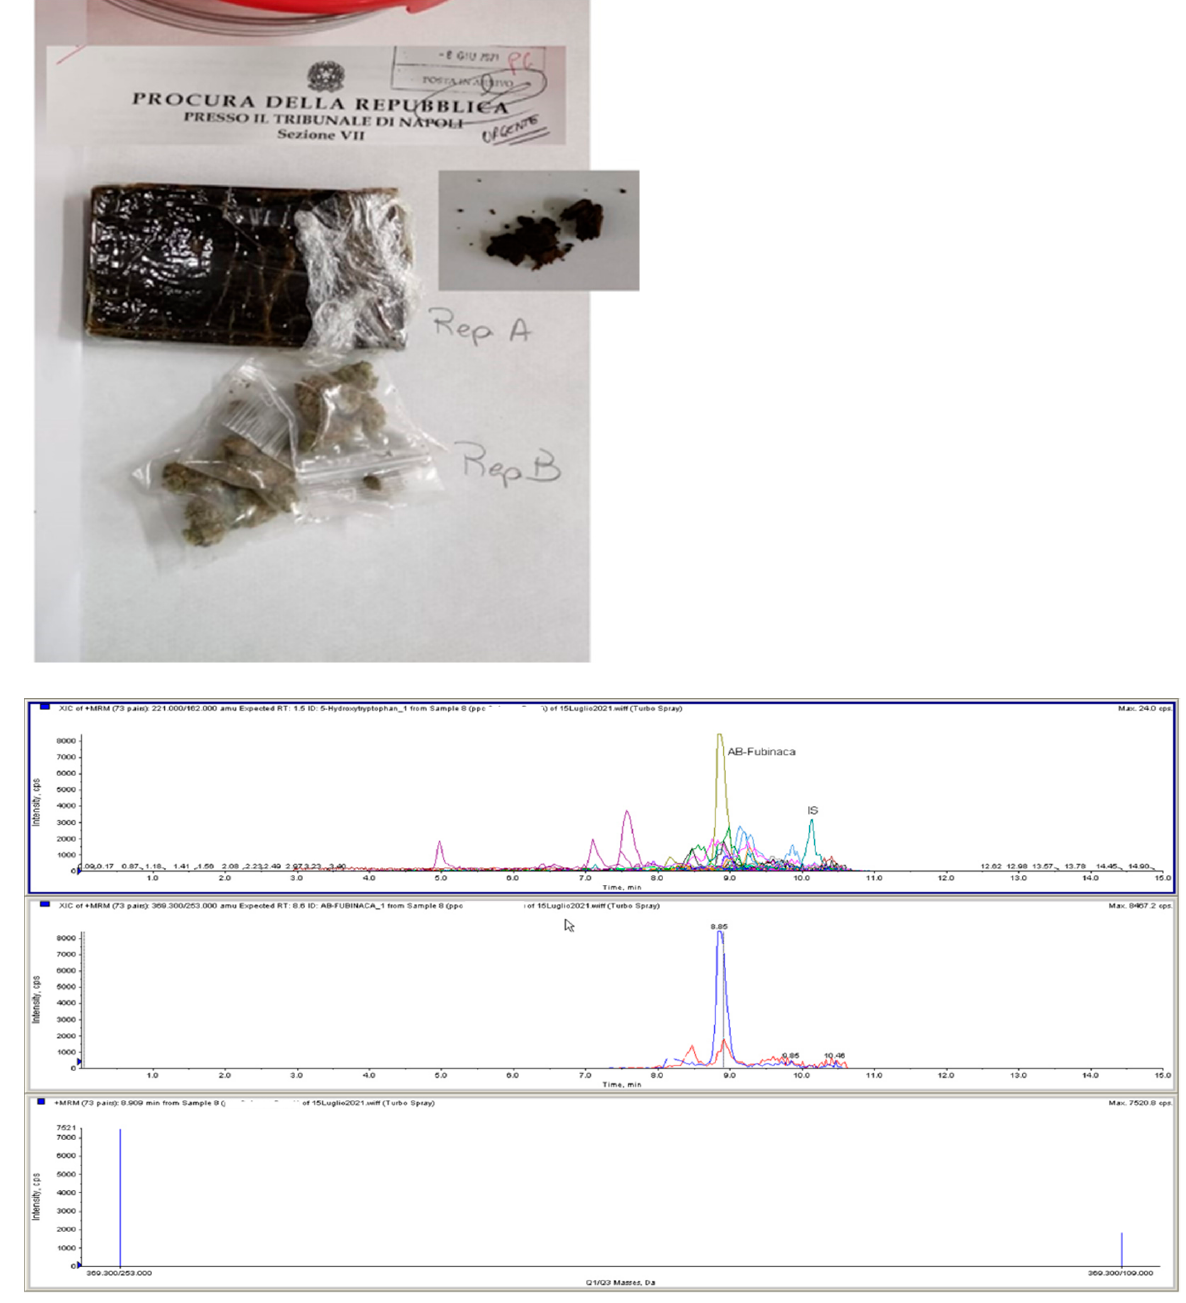
Figure 2. Case #1: a bar of cannabis resin (Rep. A) containing a low level of ∆ 9 THC (0.57%) and the synthetic cannabinoid AB-FUBINACA (graphic in LC-MS/MS) in a 4.5% concentration. In the same seizure, a second small package was found (Rep. B) containing cannabis inflorescences with 12.75% ∆ 9 THC